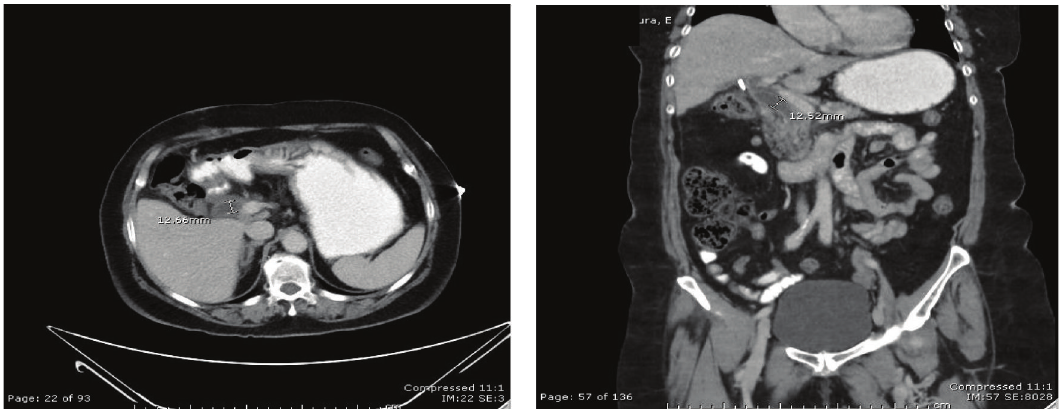
Figure2:PostoperativeCTscanabdomenwithoralandIVcontrast(axialandcoronalviews)showingdilatedcommonhepaticduct(12.5 mm diameter).